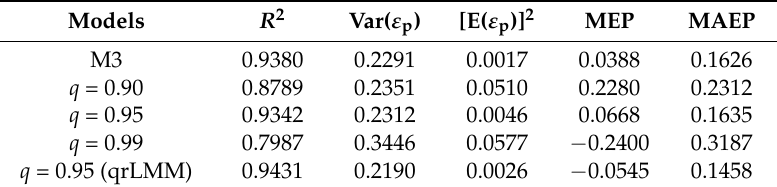
Table 5. The statistics for the third marginal model, quantile regression model (with the 0.90th, 0.95th, and 0.99th quantile), and the quantile regression for linear mixed-effects model for the 0.95th quantile.